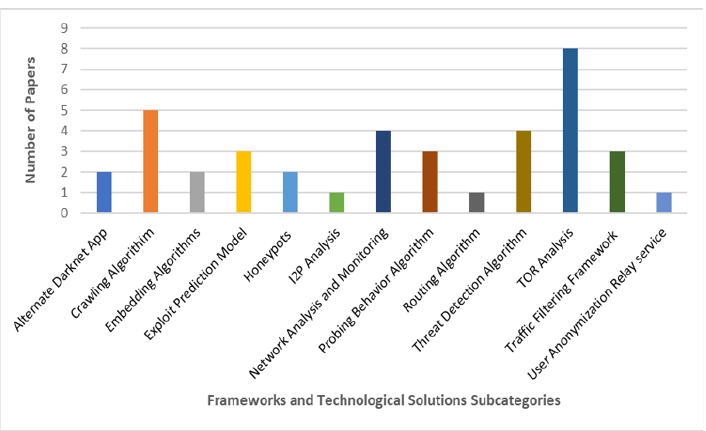
Figure 2. A snapshot of different frameworks and technology solutions of Dark Net privacy and security discussed in the papers.